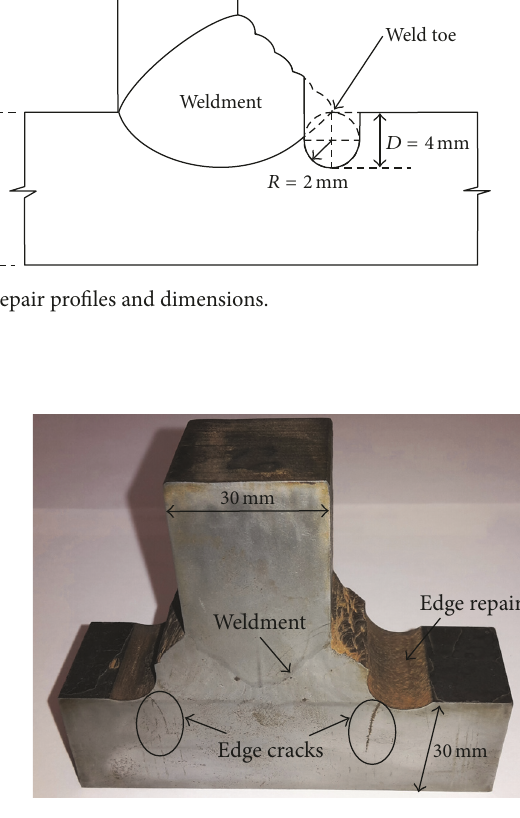
Figure 7: Slice of fatigue tested T-butt edge repaired specimen.